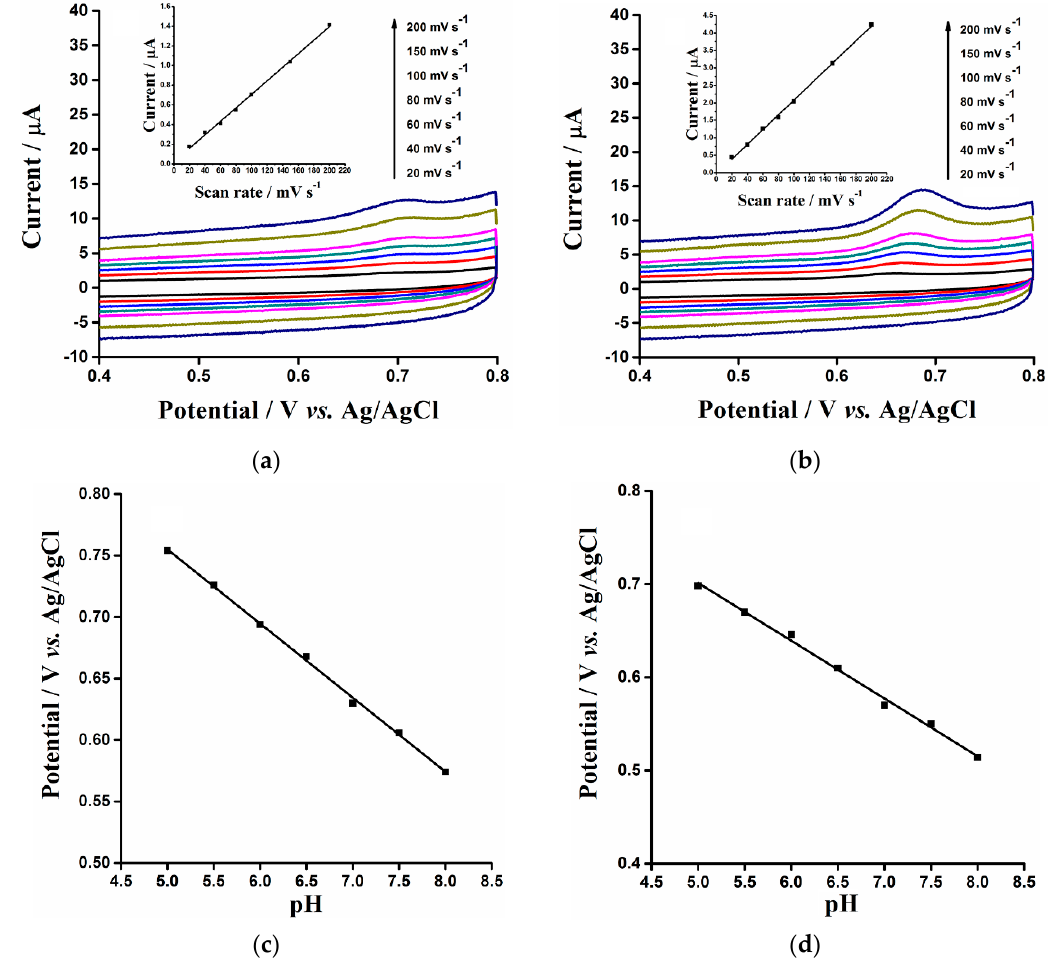
Figure 4. ( a , b ): CV of ERGO/GCE in 0.1 M phosphate buffer solution (pH 7.0) containing 5 μ M (OA) ( a ) and 5 μ M (TA) ( b ) with different scan rates (20, 40, 60, 80, 100, 150 and 200 mV·s − 1 ). The potential range: 0.4 to 0.8 V. Insets: the corresponding linear relationships between peak current and scan rate. ( c,d ): The linear relationship between pH of phosphate buffer solution (5.0, 5.5, 6.0, 6.5, 7.0, 7.5 and 8.0) and DPV anodic peak potential ( E pa ) of 5 μ M (OA) ( c ) and 5 μ M (TA) ( d ).